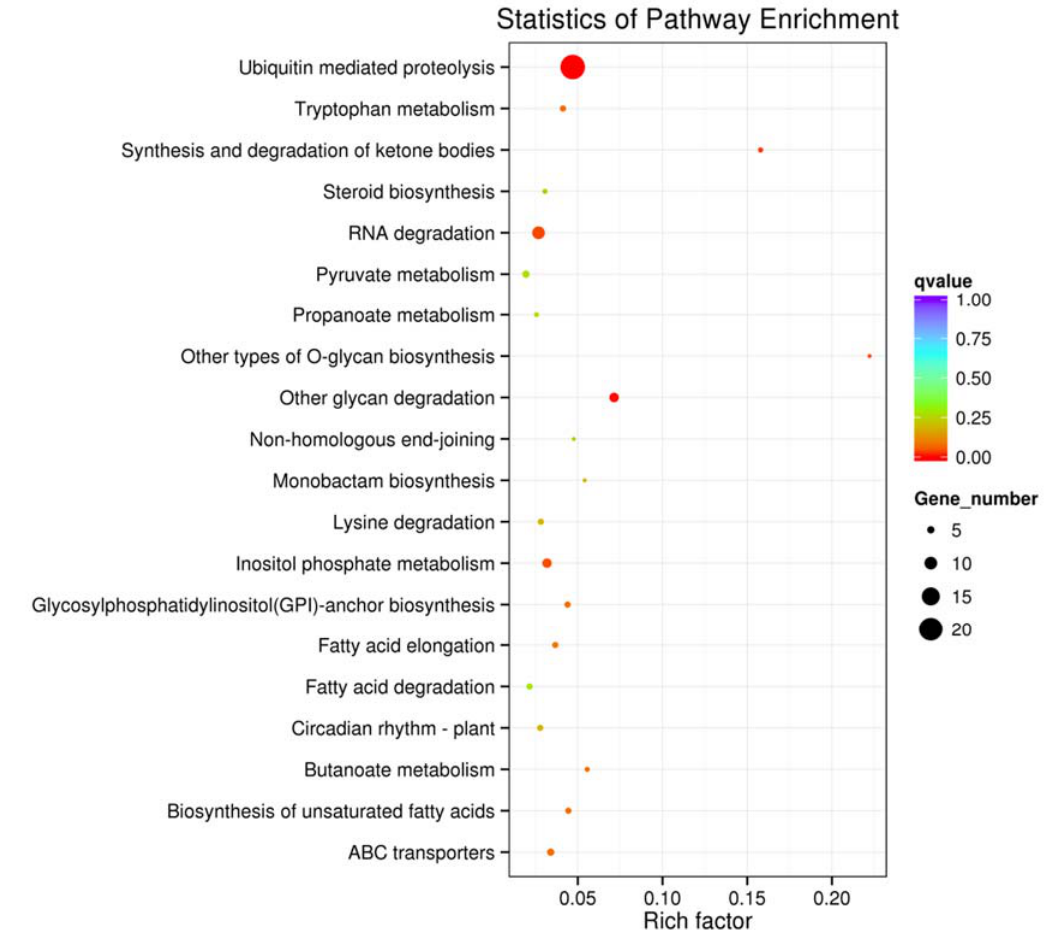
Figure 5. The 20 most enriched KEGG pathways of target genes of differentially expressed miRNAs. The x ‐ axis indicates the rich factor and the y ‐ axis indicates the pathway names.